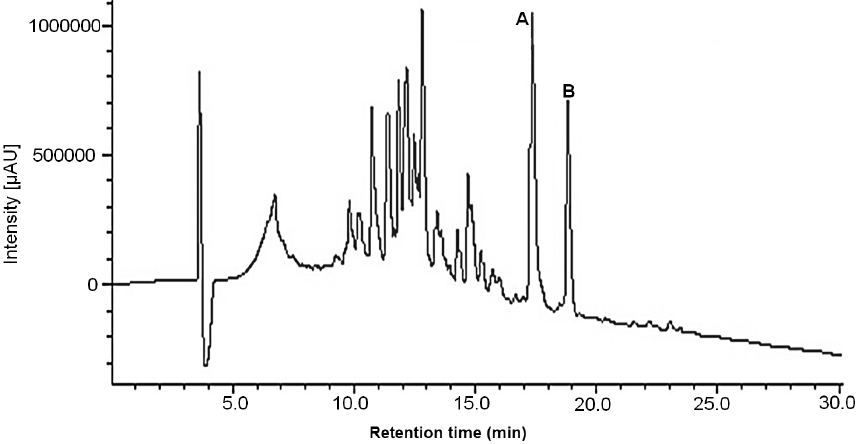
Figure 1. High-Performance Liquid Chromatography chromatogram of Asclepias subulata ethanolic extract. A: Calotropin (17.4 min), B: Calactin (18.1